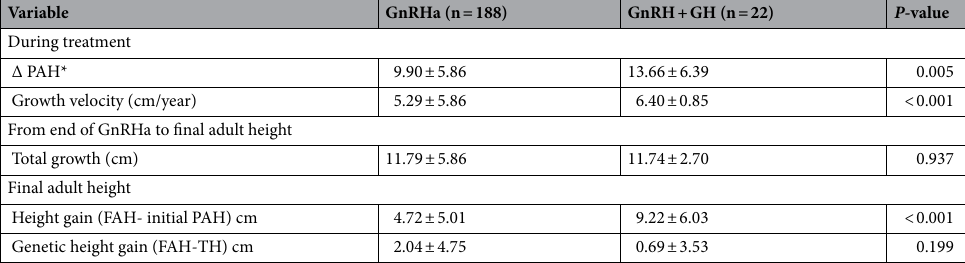
Table 3. Height outcome in subjects with GnRHa treatment or GnRHa + GH treatment. GnRHa Gonadotropin-releasing hormone agonist, GH Growth hormone, PAH predicted adult height-calculated with advanced table of baley–Pinneau(BP)method, FAH Final adult height, TH Target height. *Δ PAH: the difference between PAH at the end of treatment and initial PAH.